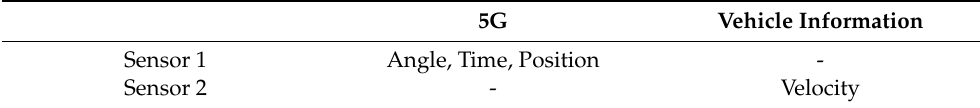
Table 1. Parameters of different sensors.